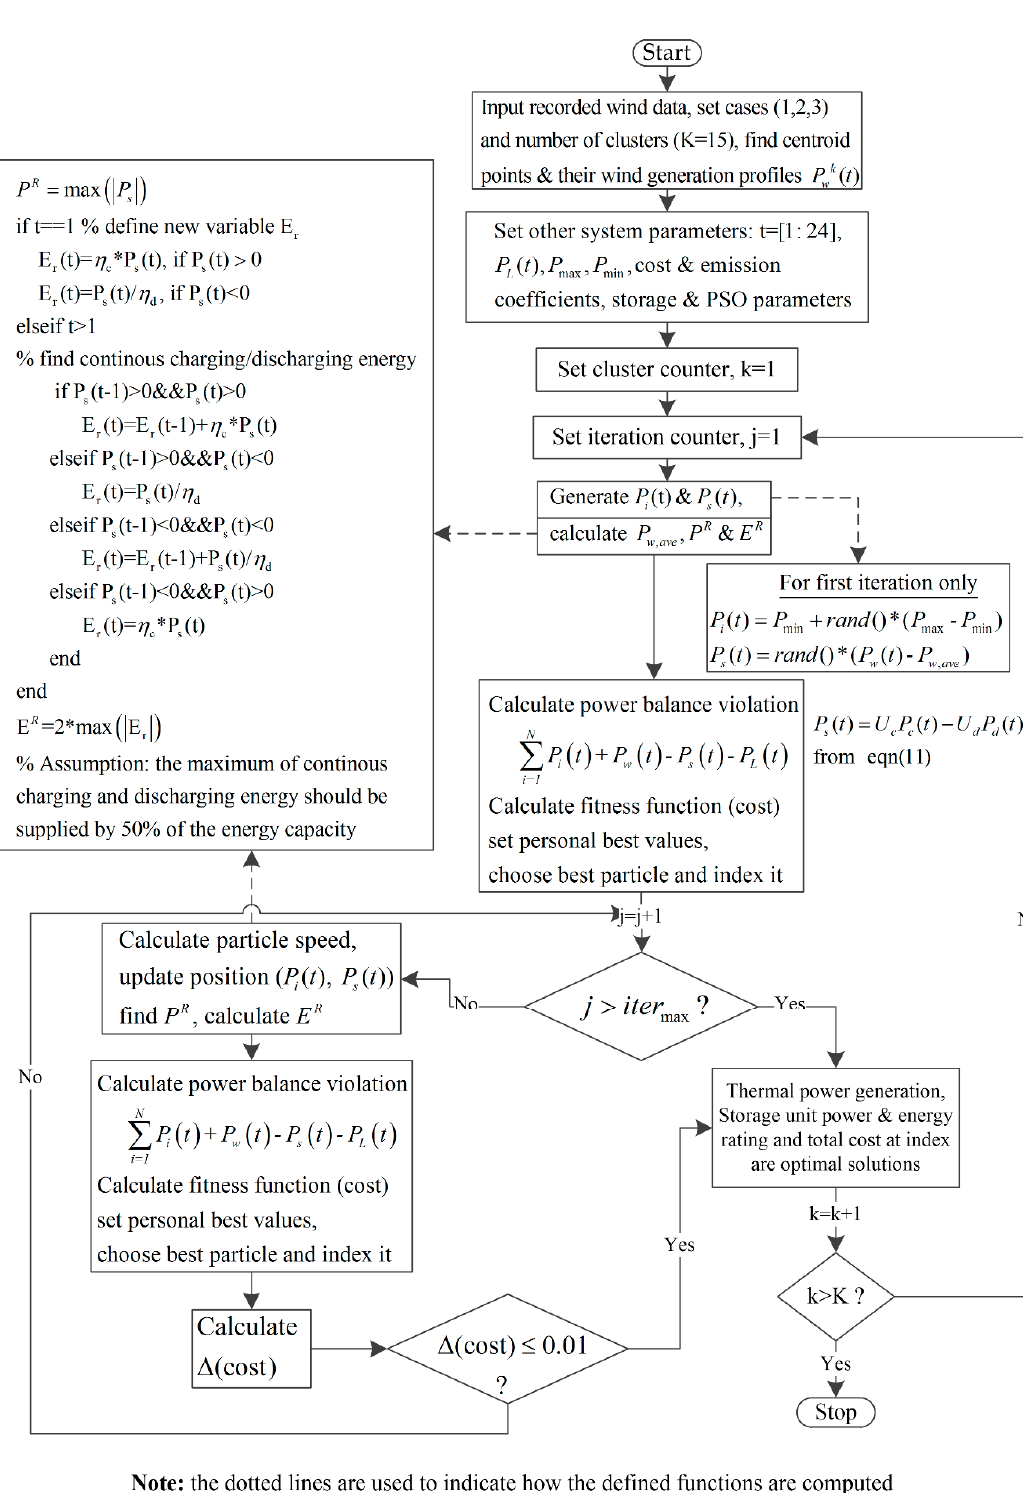
Figure 7. Flow chart of the proposed method and optimization algorithm.